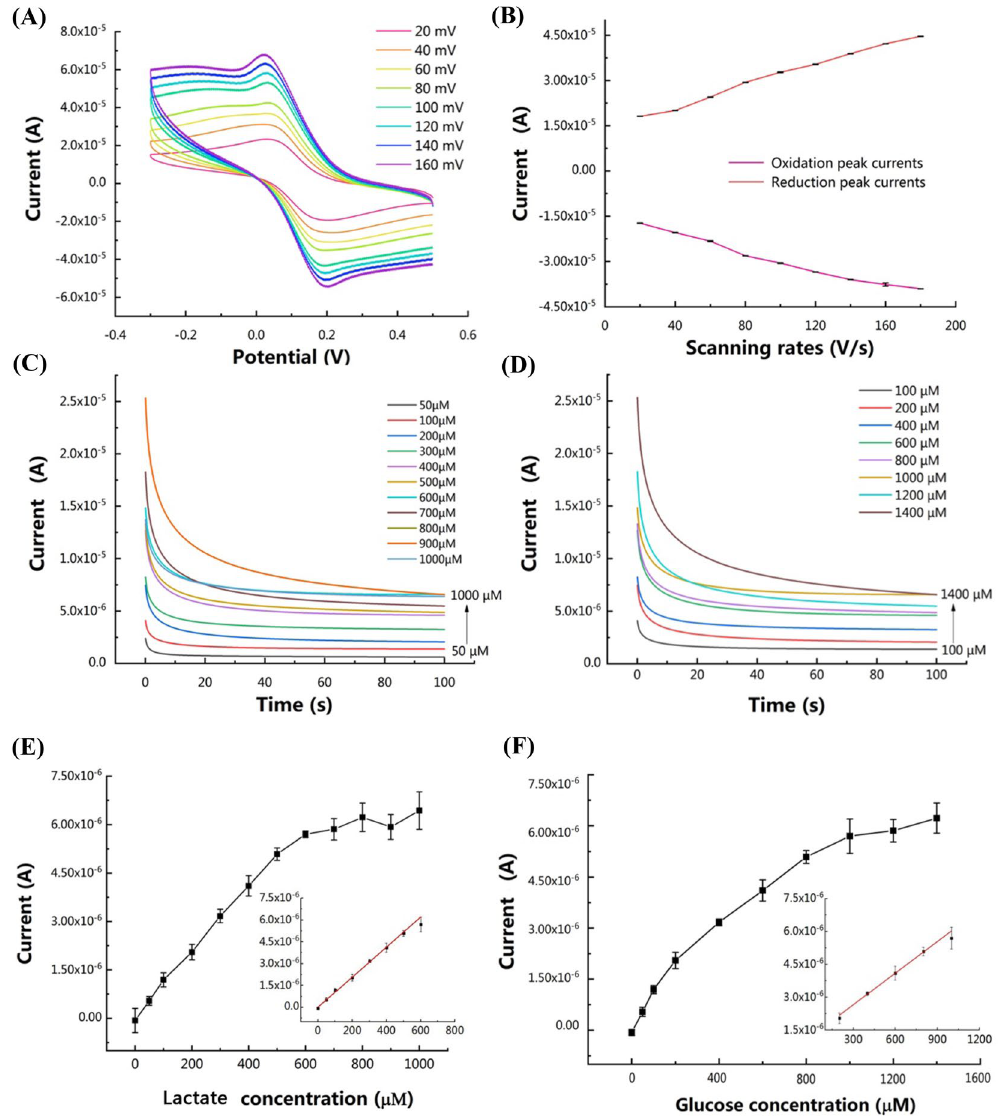
Figure 4. Electrochemical results of the dual-channel biosensor. (A) Cyclic voltammetry results of the biosensor in 100 μL potassium ferricyanide solution (0.01 M) under different scanning rates. Scanning rates: 20, 40, 60, 80, 100, 120, 140, 160, 180 mV/s. The oxidation current increased as the scanning rate increased. (B) Relationship between peak oxidation and reduction currents versus scanning rates. Error bar was plotted in black ( N = 3). The peak oxidation current increased as the scanning rate increased in a linear manner. (C) Amperometric i–t curve results of the dual-channel biosensor in 0.01 M PBS (pH 7.4) containing lactate with concentrations from 0 to 1000 μM. (D) Amperometric i–t curve results of the dual-channel biosensor in 0.01 M PBS (pH 7.4) containing glucose with concentrations from 0 to 1400 μM. (E) The relationship between peak oxidation currents and concentrations of lactate ( N = 4). The insert shows linear curve fitting between lactate concentrations and measured currents, coefficient of association R 2 = 0.9965 ( N = 4). The linear range was 0–600 μM and the sensitivity was 103.2 μA/(mM ⋅ cm 2 ) (The area of the working electrode was 0.1 cm 2 ). (F) The relationship between peak oxidation currents and concentrations of glucose ( N = 4). The insert shows linear curve fitting between glucose concentrations and measured currents, coefficient of association R 2 = 0.9941 ( N = 4). The linear range was 200–1000 μM and the sensitivity was 48.0 μA/(mM ⋅ cm 2 ) (the area of the working electrode was 0.1 cm 2